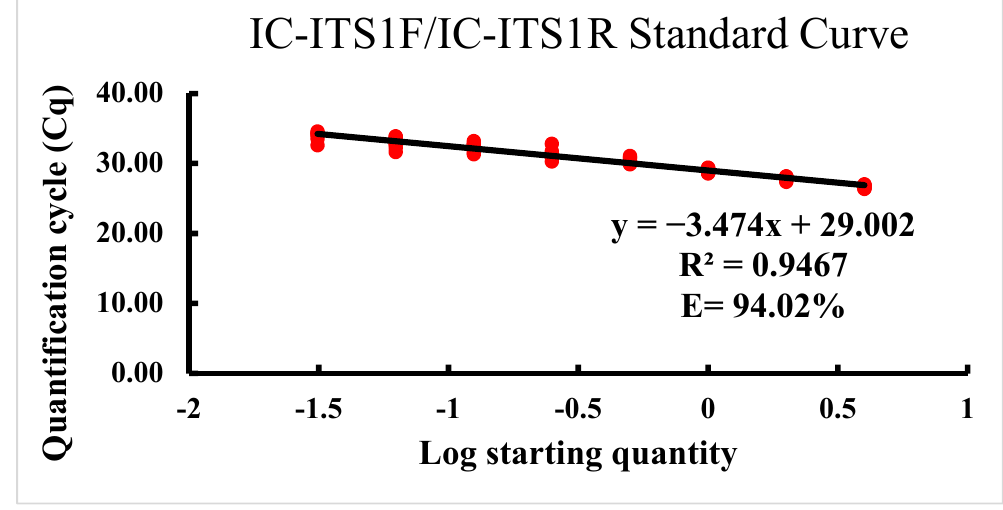
Figure 3. Standard curve of the real-time PCR assay for the new species of Pratylenchus detected in a soybean field of North Dakota: quantification cycle number (Cq) plotted against the log number of individuals of P. dakotaensis by sequential two-fold dilutions (4, 2, 1, 1/2, 1/4, 1/8, 1/16, 1/32, and 1/64). Each red dot represents an independent reaction run in triplicate for three biological replicates at each dilution level. The efficiency (E) of amplification was calculated as E = 1 1/- m − 1, where m indicates the slope.